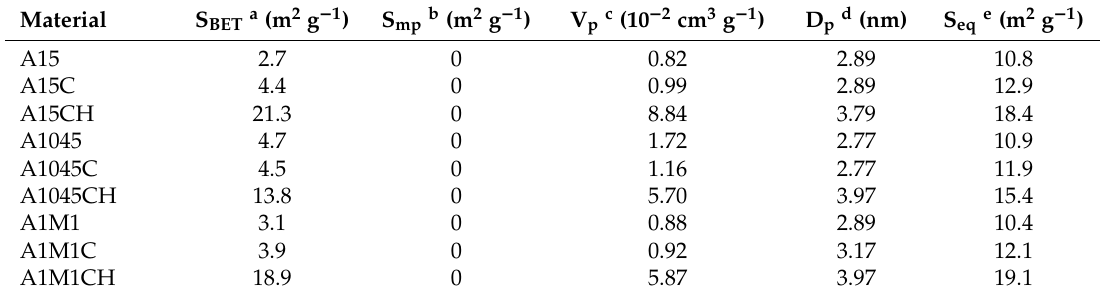
Table 1. Physicochemical properties of pristine calcites, calcined and